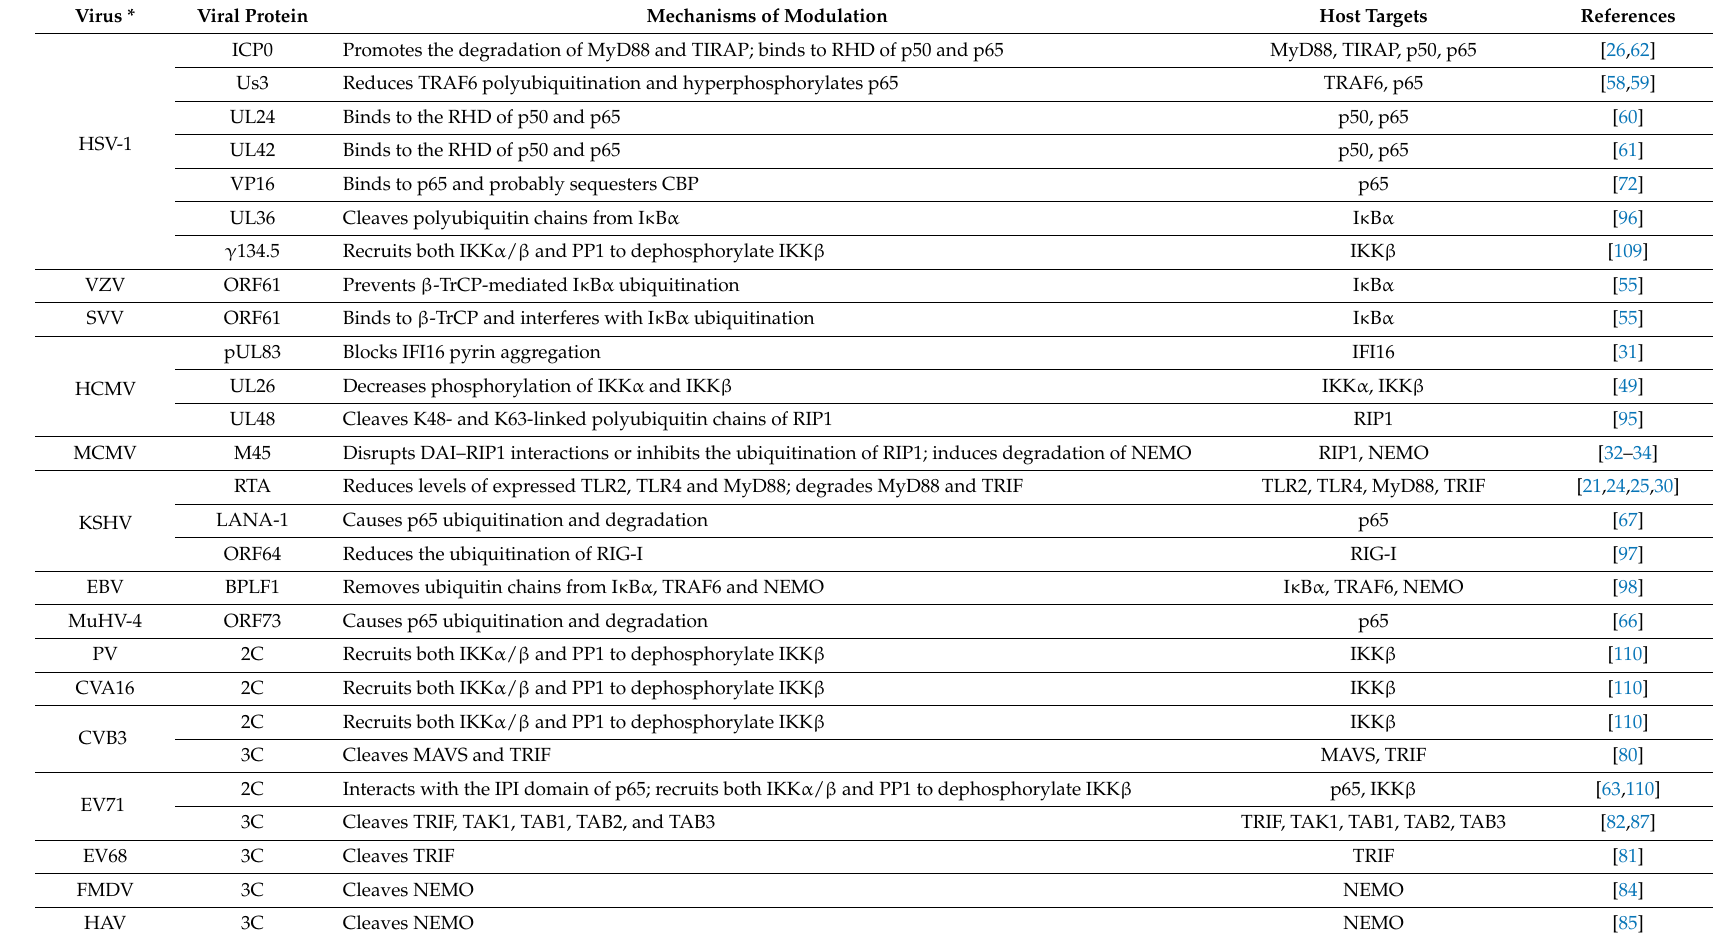
Table 1. Viruses inhibit NF- κ B